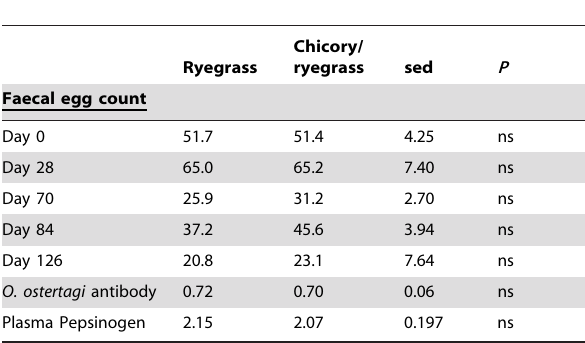
Table 4. Faecal egg count (g/DM) (square root transformed), O. ostertagi antibody (as Optical Density Ratio) or plasma pepsinogen (expressed as units of tyrosine (U)) levels of beef steers ( n = 48) in their first grazing season.